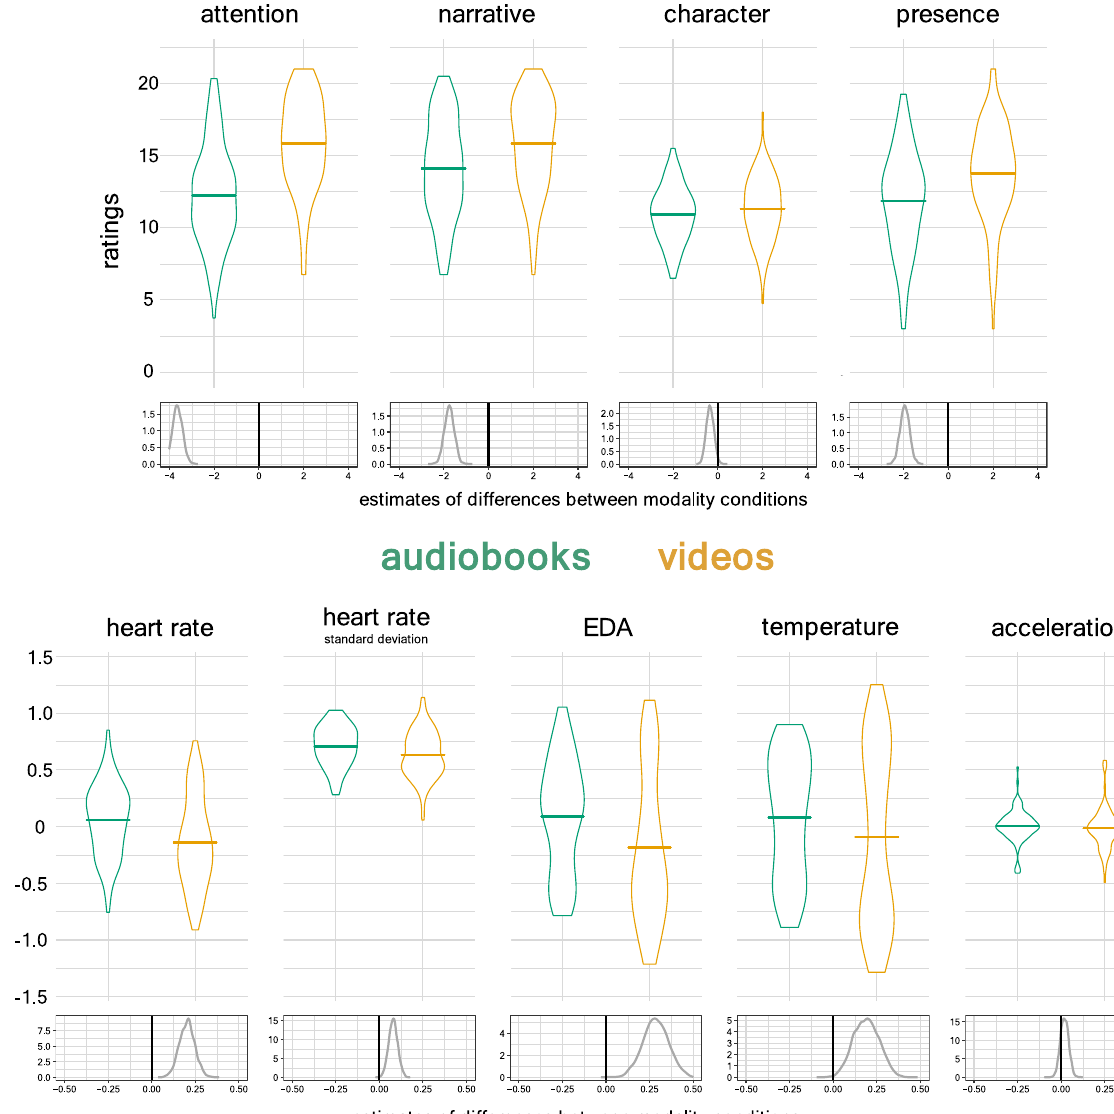
derived from Bayesian mixed models. Grey shaded areas represent 95% credible intervals. When this region does not include the black line of zero difference, there is strong evidence supporting a difference between